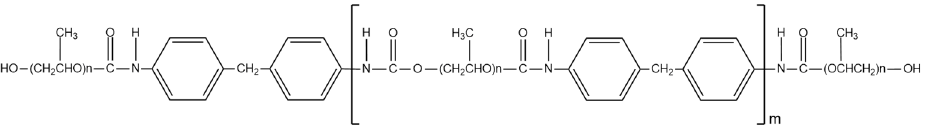
Figure 4. Chemical structure of LSMM.